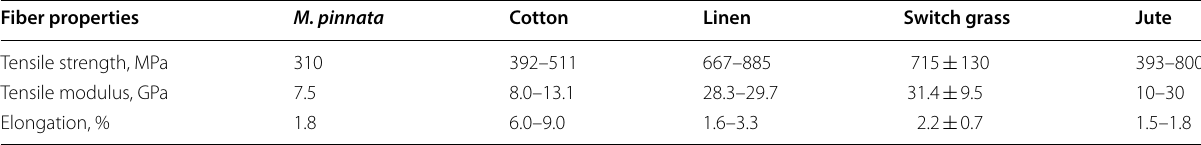
Table 2 Comparison of the tensile properties of M. pinnata fibers and other common sources of plant fiber (Guna et al. 2019c; Ilangovan et al.